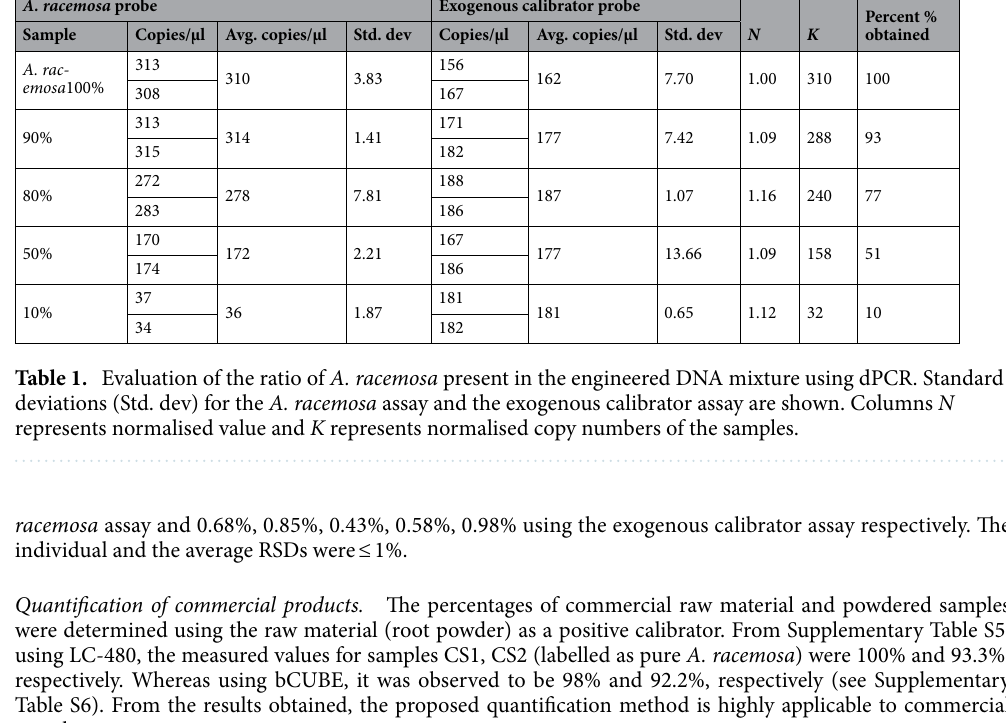
ing between 0.125 ng/μl and 0.5 ng/μl.